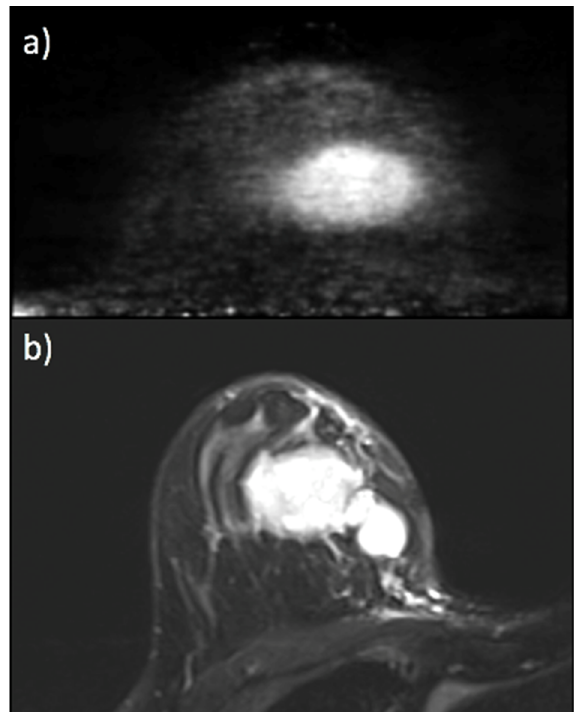
Figure 8. ( a ) BRPET scan of the right breast of a subject with a known malignancy originally seen on a 2D mammogram and then staged with CEMRI, seen in ( b ). The image comparison in this case strongly suggests that the base of the breast is visible in the PET image.